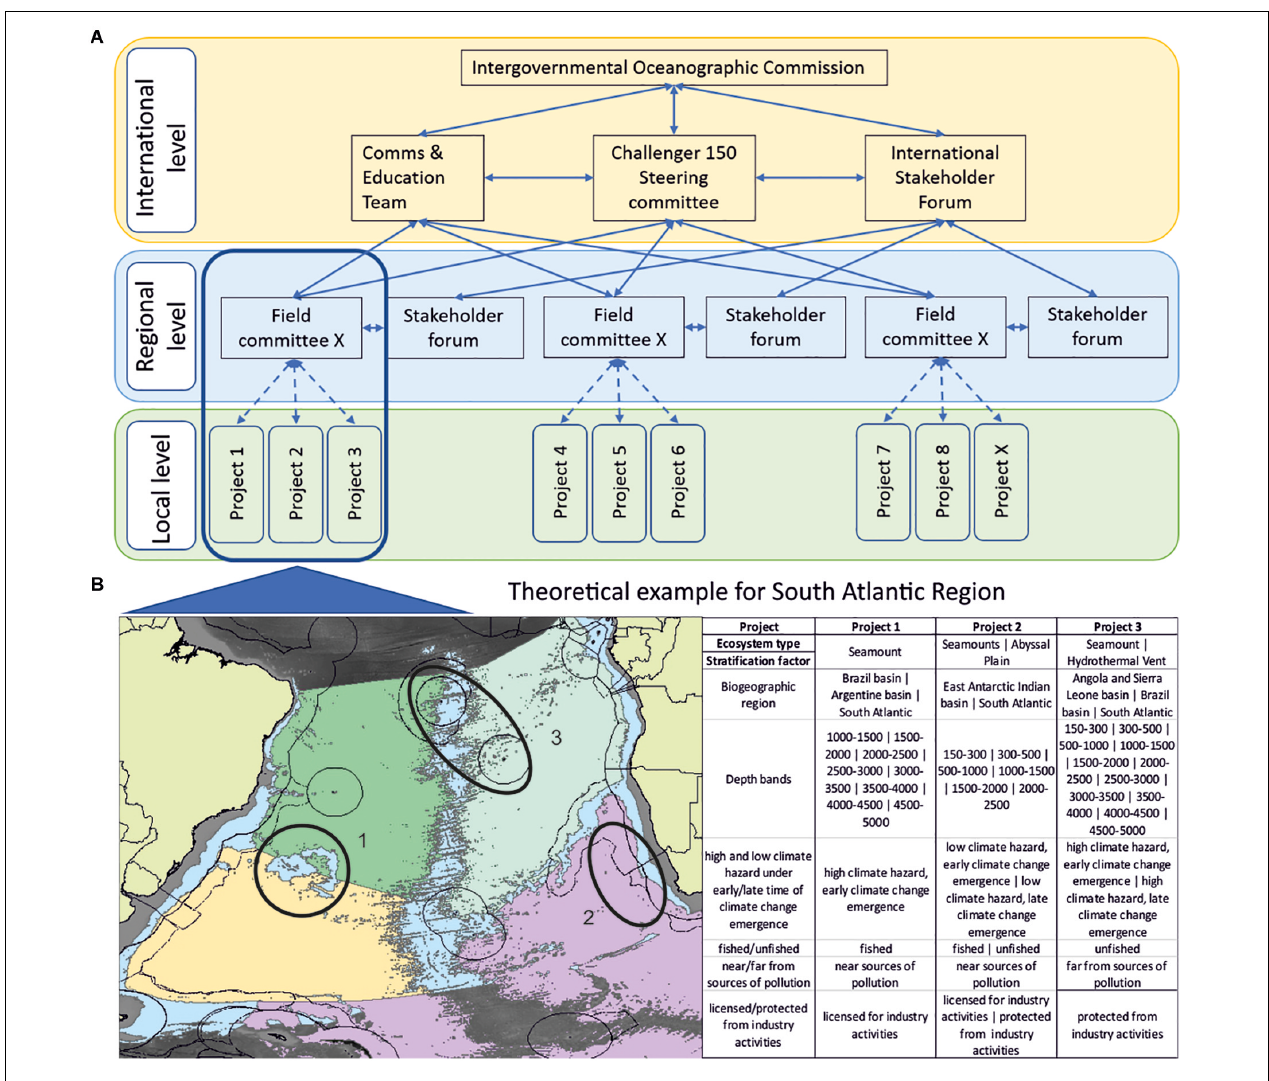
FIGURE 2 | A framework for realizing the Challenger 150 Ocean Decade ‘Program-level Action’ concept, using the South Atlantic as an example region. (A) A proposed management structure for the program. (B) An example of how different projects operating within a region will be monitored against the global design and gaps in survey coverage